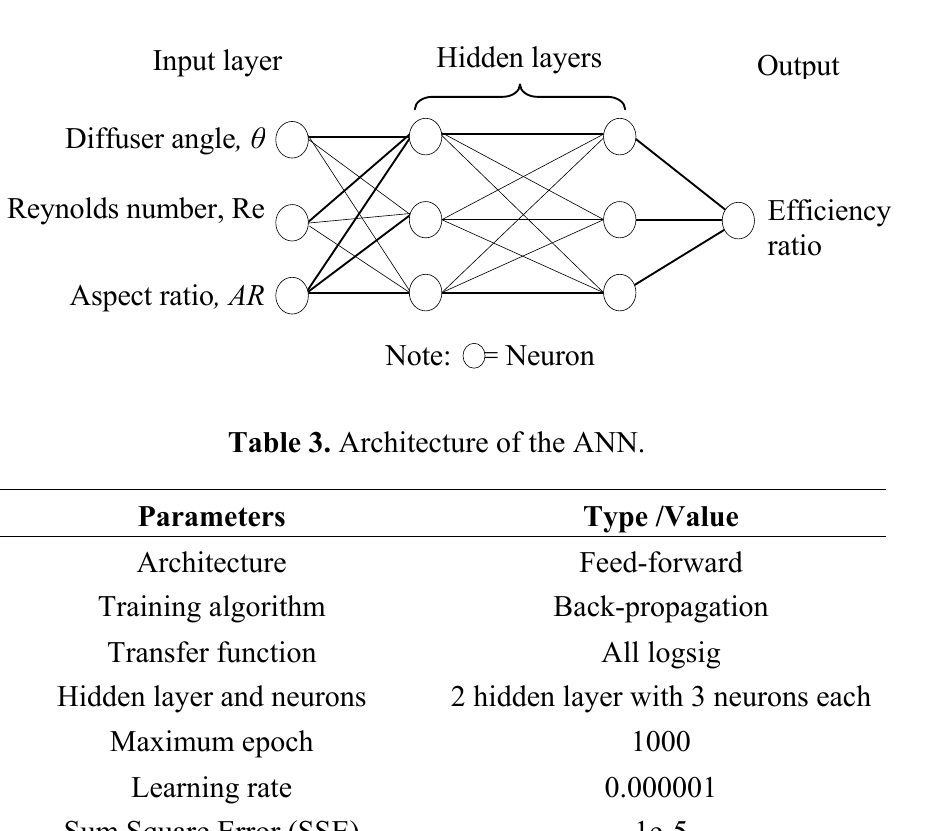
Figure 5. Illustration of the artificial neural network model.